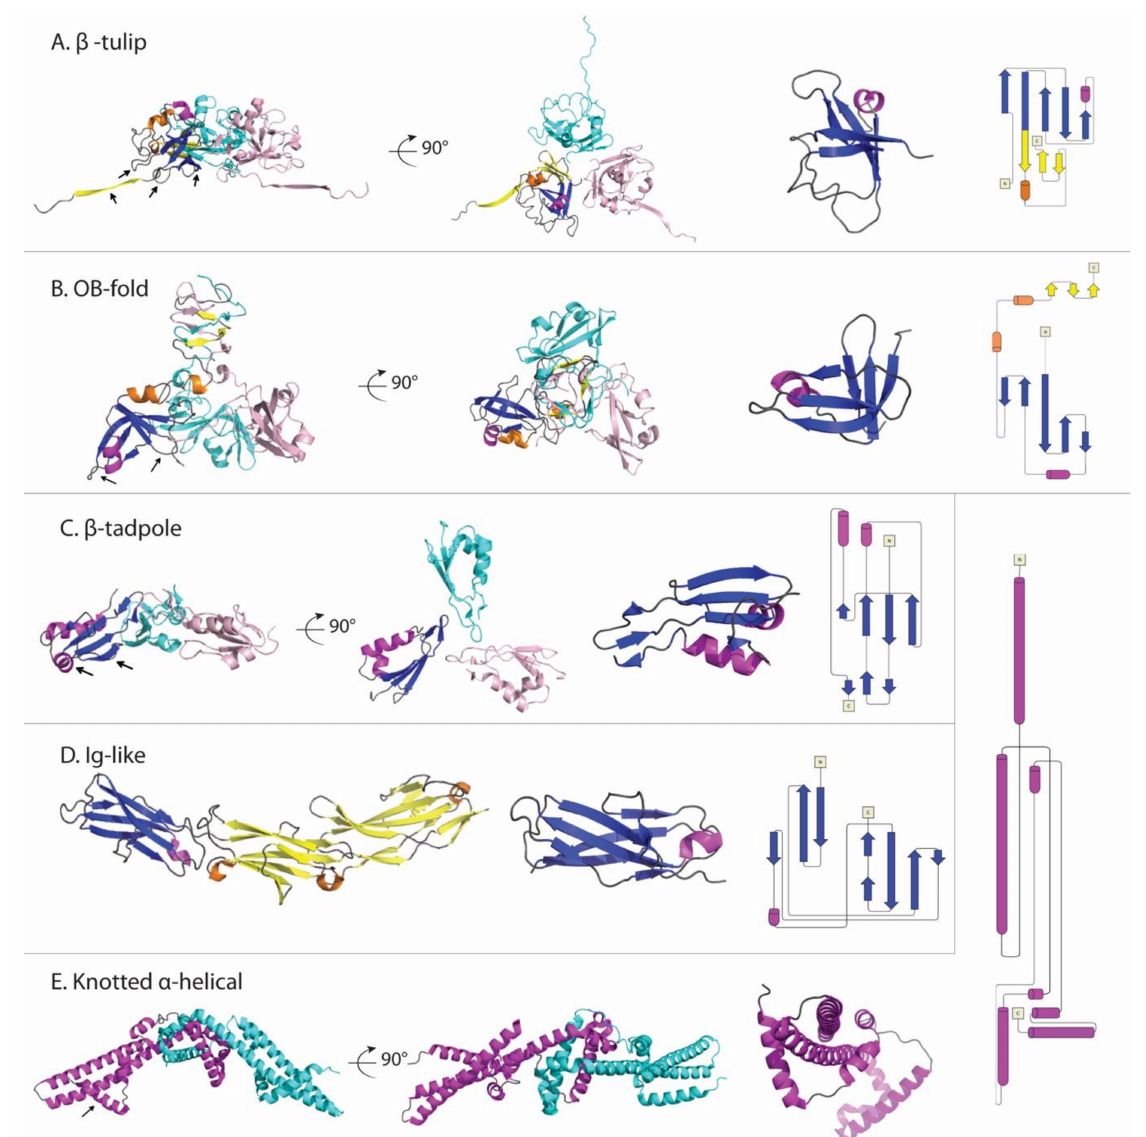
Figure 2. Comparison of decoration protein structures. ( A ) β -Tulip fold illustrated by gp87 (P74-26), PDB 6O3H. ( B ) OB-fold in Dec (L), PDB 6E3C. ( C ) β − Tadpole fold in Soc (T4), PDB 3IG9. ( D ) Ig-like fold exemplified by Hoc (T4), PDB 3SHS. ( E ) Knotted α -helix fold shown by Psu (P4), PDB 3RX6. The first two views in each panel are related by a 90 ◦ x-axis rotation. The first is parallel to the capsid surface, with the bottom of each structure corresponding to the parts of the protomer (denoted by arrows) involved in contacting the capsid surface. The second view is looking down towards the surface of the capsid. The last two panels show the protein fold, and a corresponding topology diagram. For each structure except the last, one protomer is colored with blue and purple indicating β -strands and α -helices within the conserved fold, while yellow and orange highlight β -strands and α -helices in non-conserved